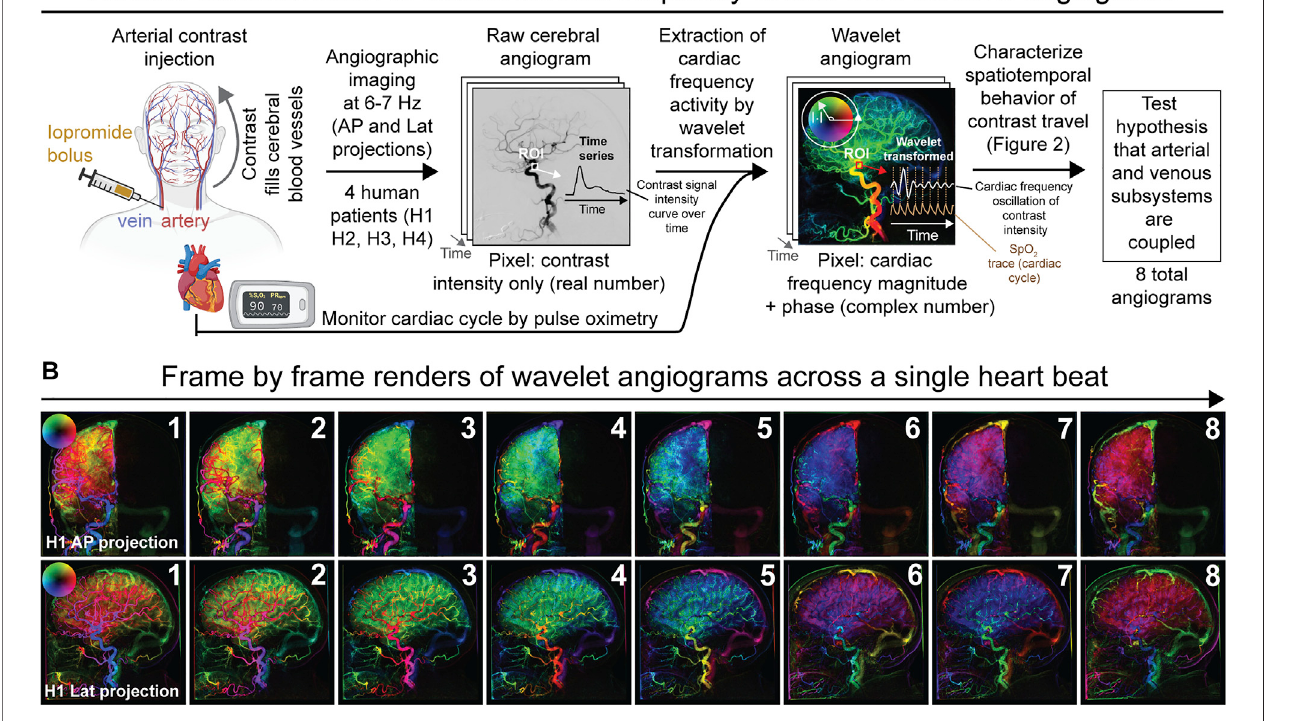
Frontiers in Bioengineering and Biotechnology |